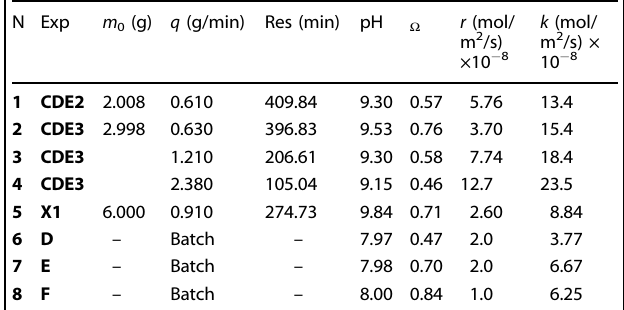
Table 5. Experimental conditions with m the initial mass of calcite, q the fl ow rate and Res the residence time of the solution in the